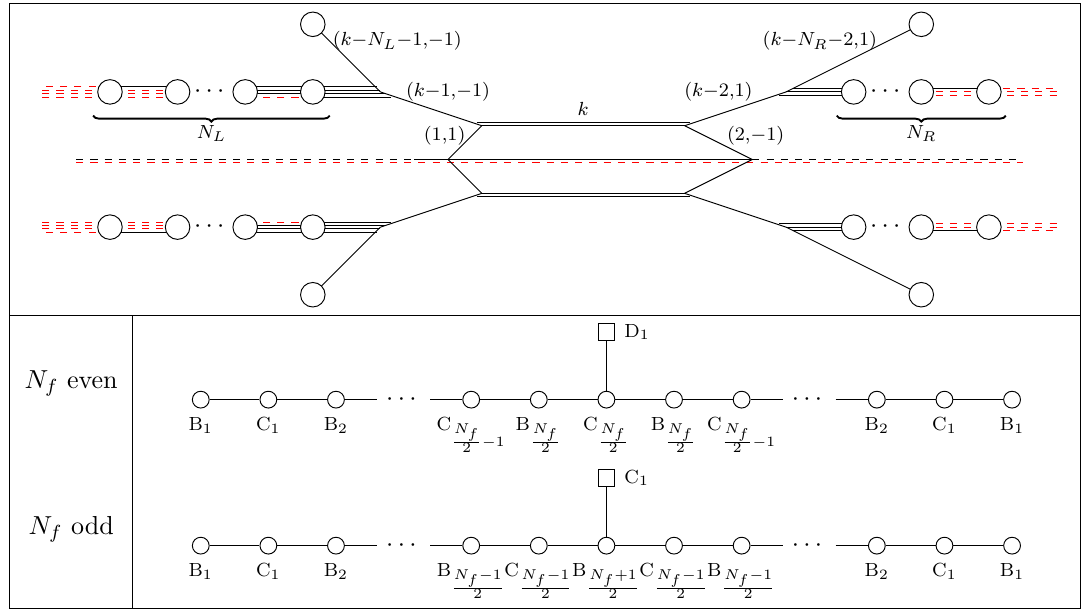
Table 10 . Brane web for O(2 k + 1) with N f = N L + N R (cid:13)avours. On a generic point of the Higgs branch O(2 k + 1) with N f (cid:13)avours is broken to pure O(2 k + 1